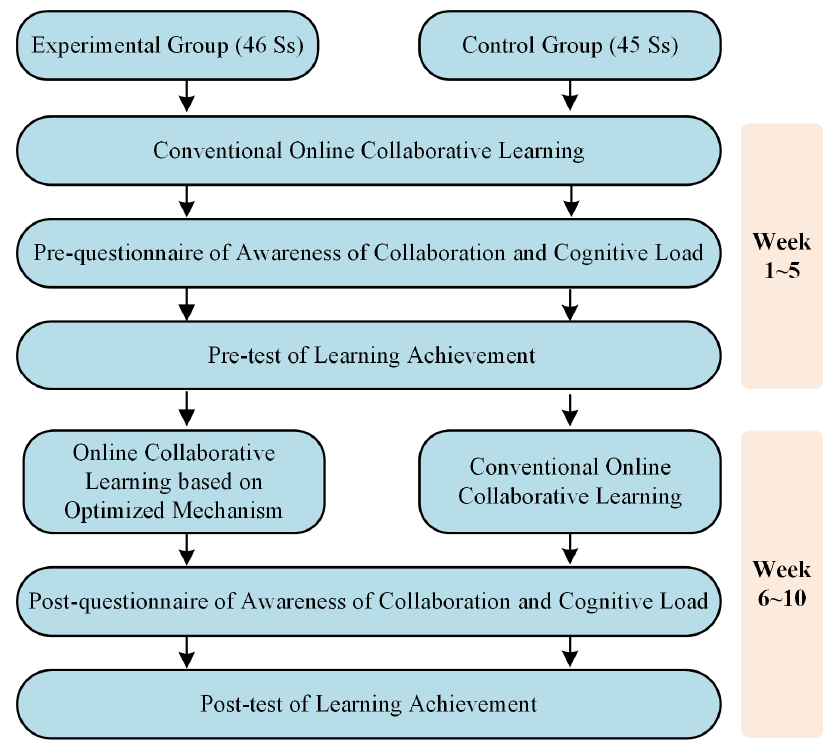
Figure 5. Experimental procedure.